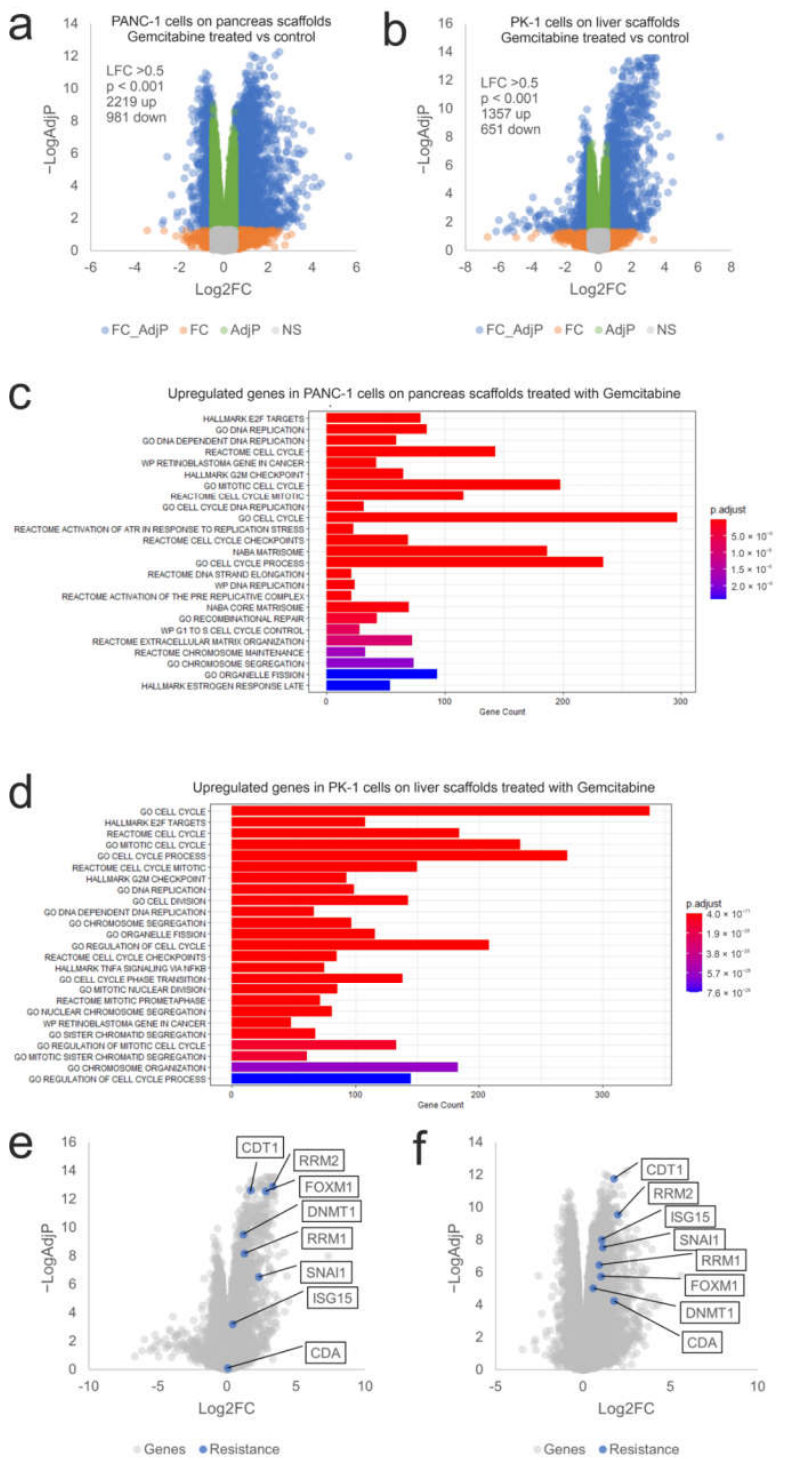
Figure 6. Transcriptional response of PANC-1 and PK-1 cells treated with gemcitabine on their native scaffolds. Volcano plots of ( a ) PANC-1 and ( b ) PK-1 cells treated with 0.5 μM gemcitabine on their native scaffolds. Blue symbols represent genes showing significantly altered expression (LFC > 0.5, p < 0.05). Functional analysis of the overexpressed genes identified in ( c ) PANC-1 and ( d ) PK-1 cells treated with gemcitabine. Expression of a panel of genes related to gemcitabine resistance in ( e ) PANC-1 and ( f ) PK-1 cells are indicated in blue. ( n = 3 per